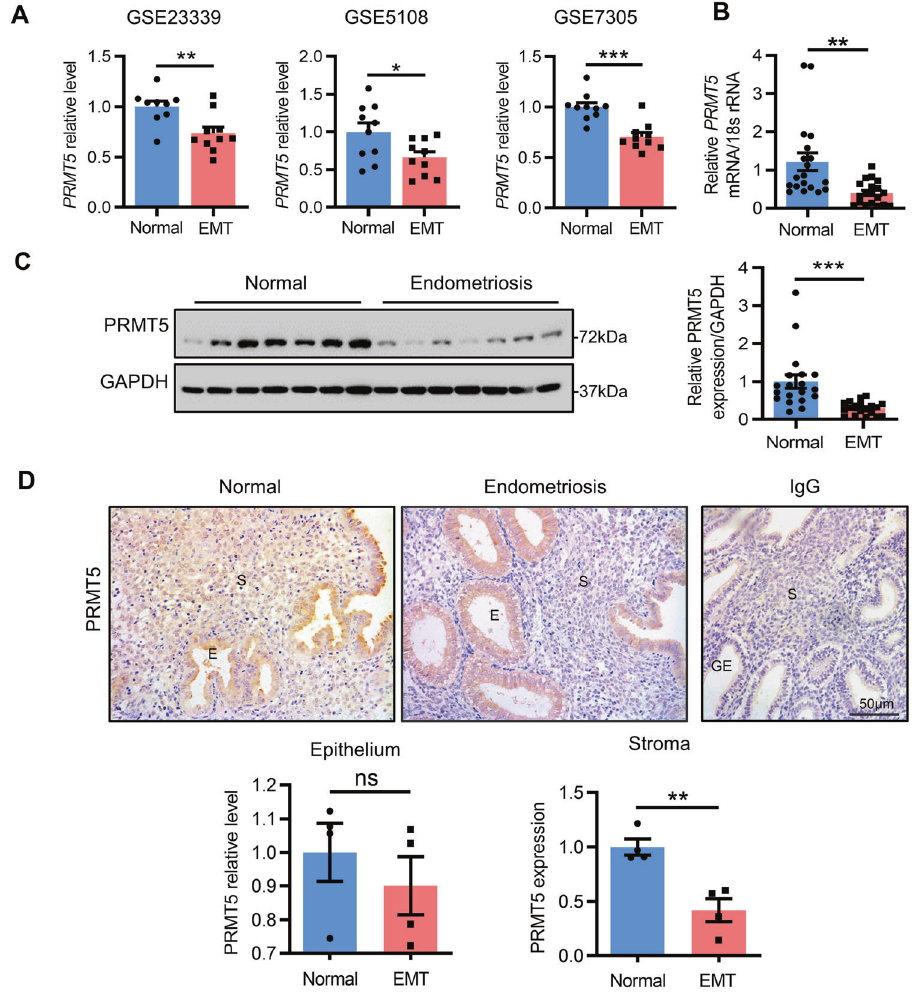
Fig. 1 Decreased expression of PRMT5 in the endometrial stromal cells of endometriosis patients. A The mRNA levels of PRMT5 in the ectopic endometrium from women with endometriosis (EMT) and endometrium of healthy controls from GSE23339, GSE5108 and GSE7305. B qRT – PCR analysis and C Western blot analysis of PRMT5 in the mid-secretory phase eutopic endometrium from women with (EMT: n = 19) or without (normal: n = 19) endometriosis. D IHC analysis of PRMT5 in the mid-secretory phase eutopic endometrium from women with (EMT: n = 4) or without (normal: n = 4) endometriosis. Scale bar = 50 µm; E epithelium, S stroma. Means ± SEM. * P < 0.05, ** P < 0.01, *** P < 0.001, Student ’ s t